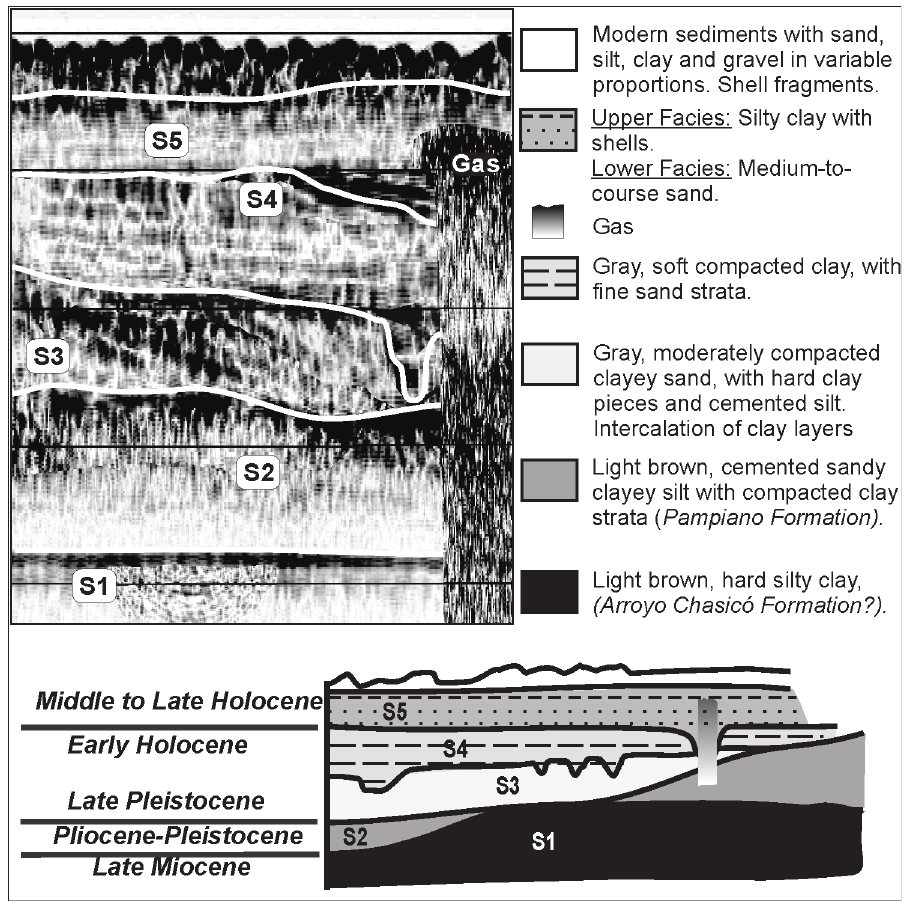
Fig. 7 - Deltaic sequences stratigraphy (S3 and S4). Seismic and lithological